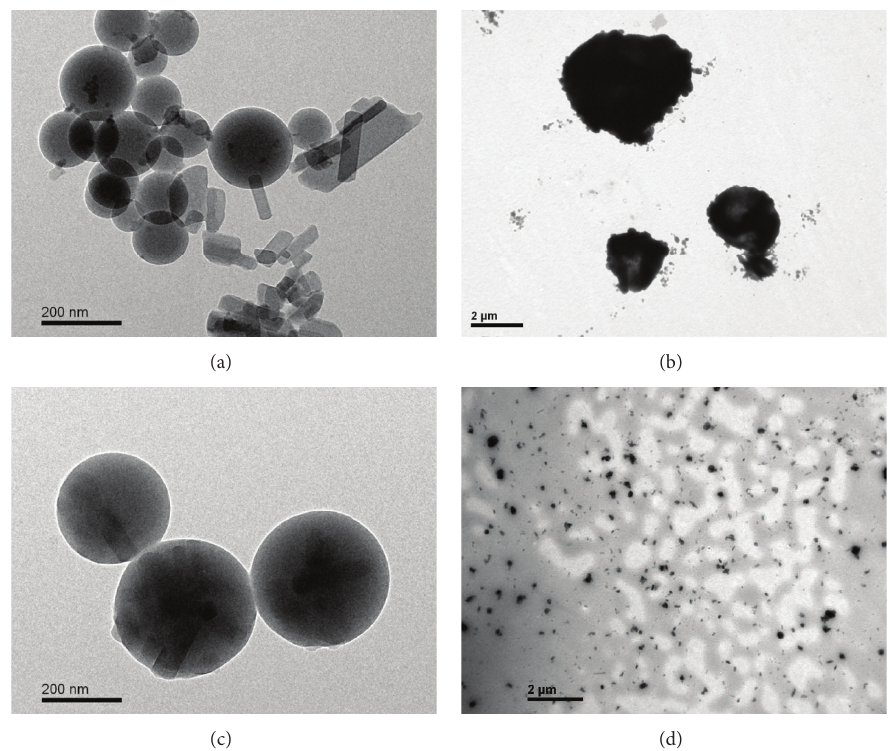
Figure 3: Typical TEM micrographs of organic pigment microcapsules PSt-PB (a), P(BA+St)-PB (b), PSt/PB (c), and P(BA+St)/PB